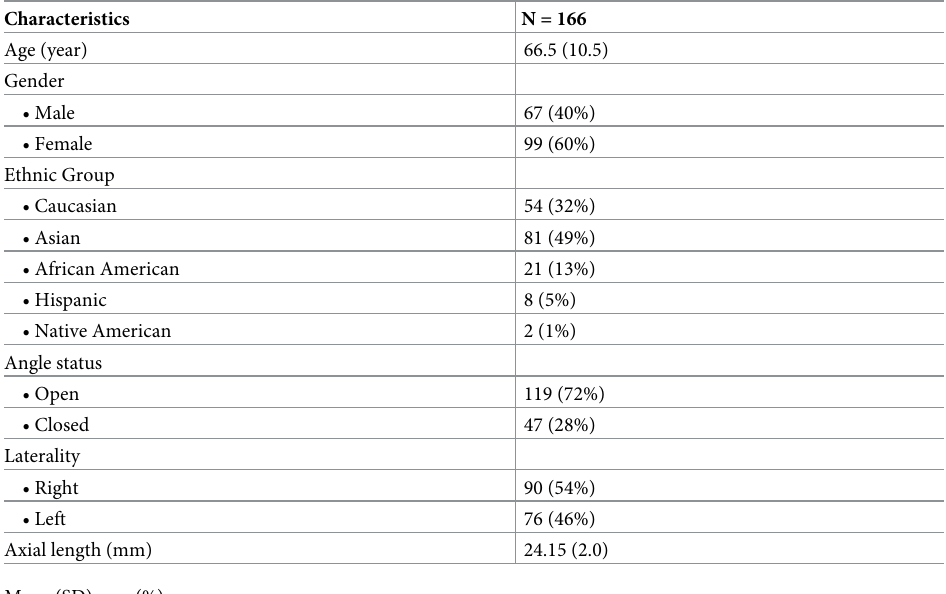
Table 1. Clinical